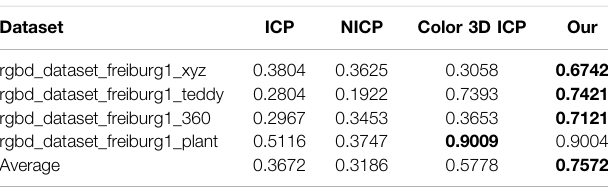
TABLE 2 | Fitness index comparison table.